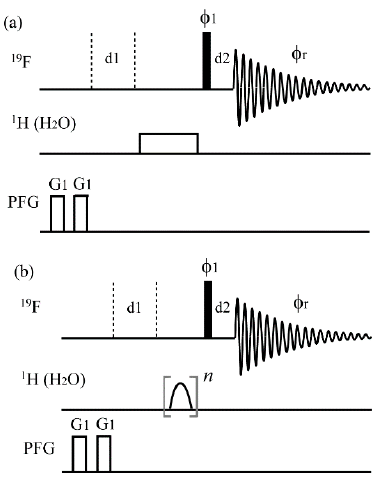
Figure 2. The pulse sequences of 19 F water ligand observed via gradient spectroscopy